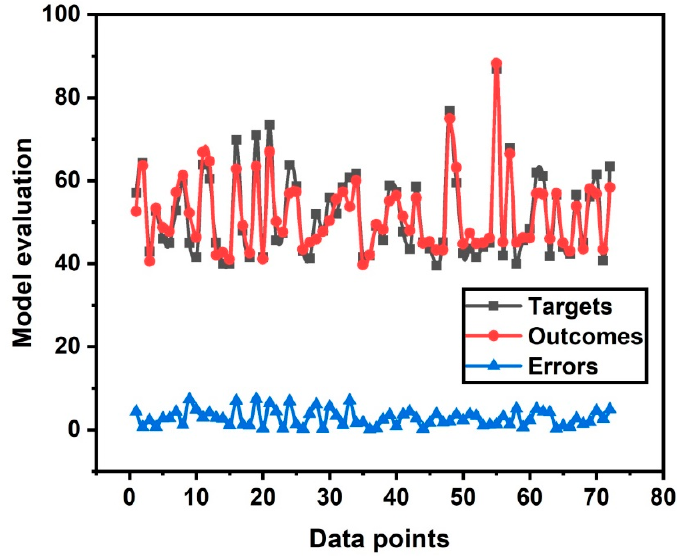
Figure 5. Distribution of data with error range.